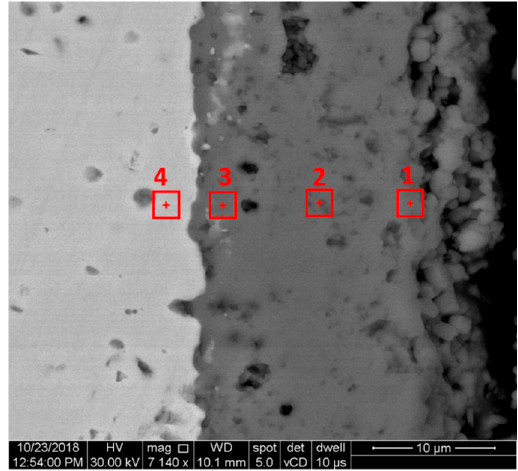
Figure 4. EDS analysis microareas in specimen’s cross-section. Table 2. Chemical composition evolution in the studied four microareas (oxidation at 900 °C). Exposure Time